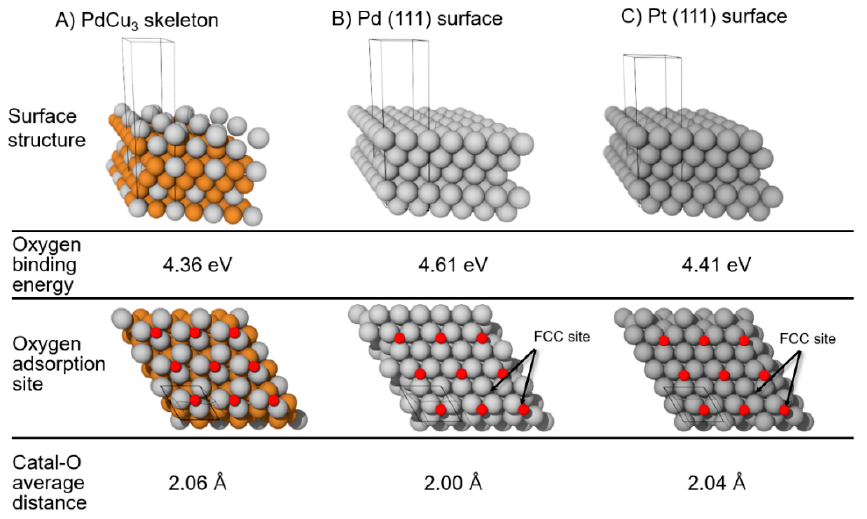
Figure 8. Schematic illustration of “Cu-free surface structures”, which were formed by electrochemical dealloying. Reproduced with permission [95]. Copyright 2018, Royal Chemical Society.